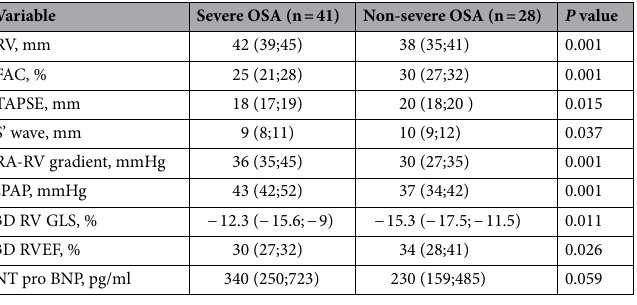
Table 5. Comparison between severe OSA patients vs non severe OSA